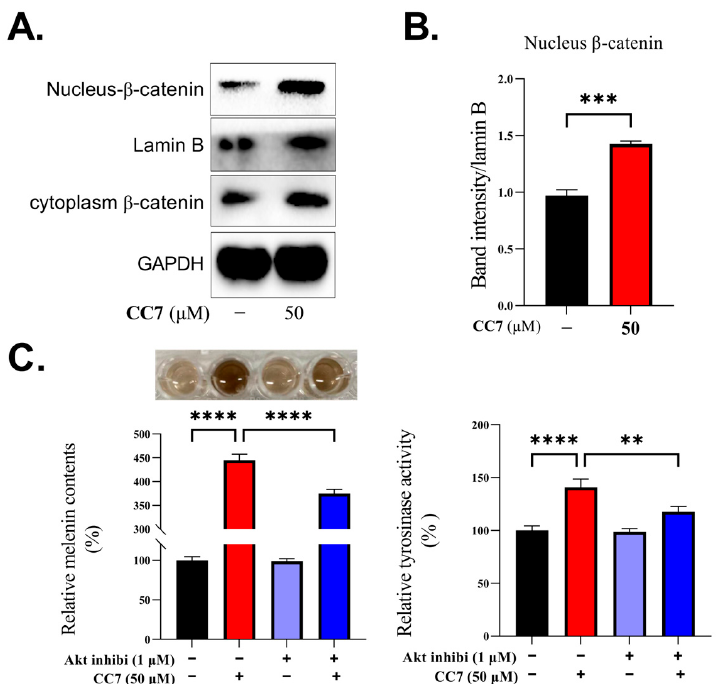
Figure 7. The effects of CC7 on Akt/GSK3 β / β -catenin signal pathway in B16 cells. ( A ) Western blotting results of protein expression levels of β -catenin in cytoplasmic and nuclear fractions in B16 cells after treatment with CC7 at 50 µ M. ( B ) The quantification of western bands, and results are presented as the mean ± SD from three independent measurements using Image J